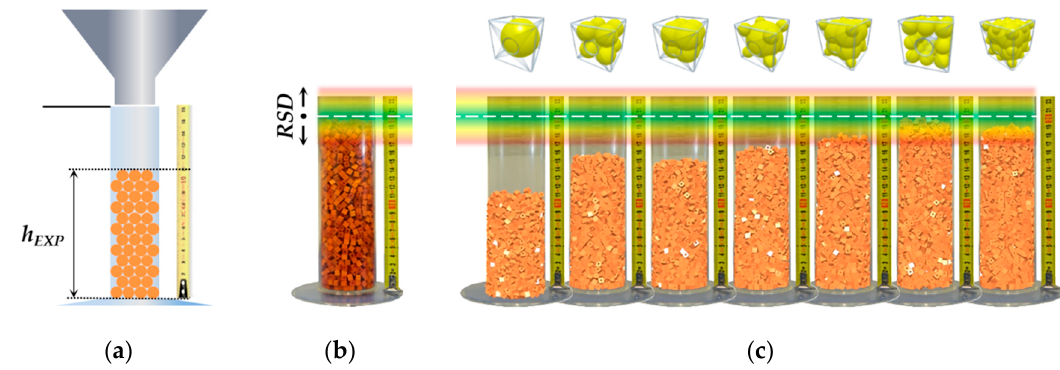
Figure 4. Packing test: ( a ) scheme; ( b ) experiment result; ( c ) DEM simulations’ results with different particles clumps.